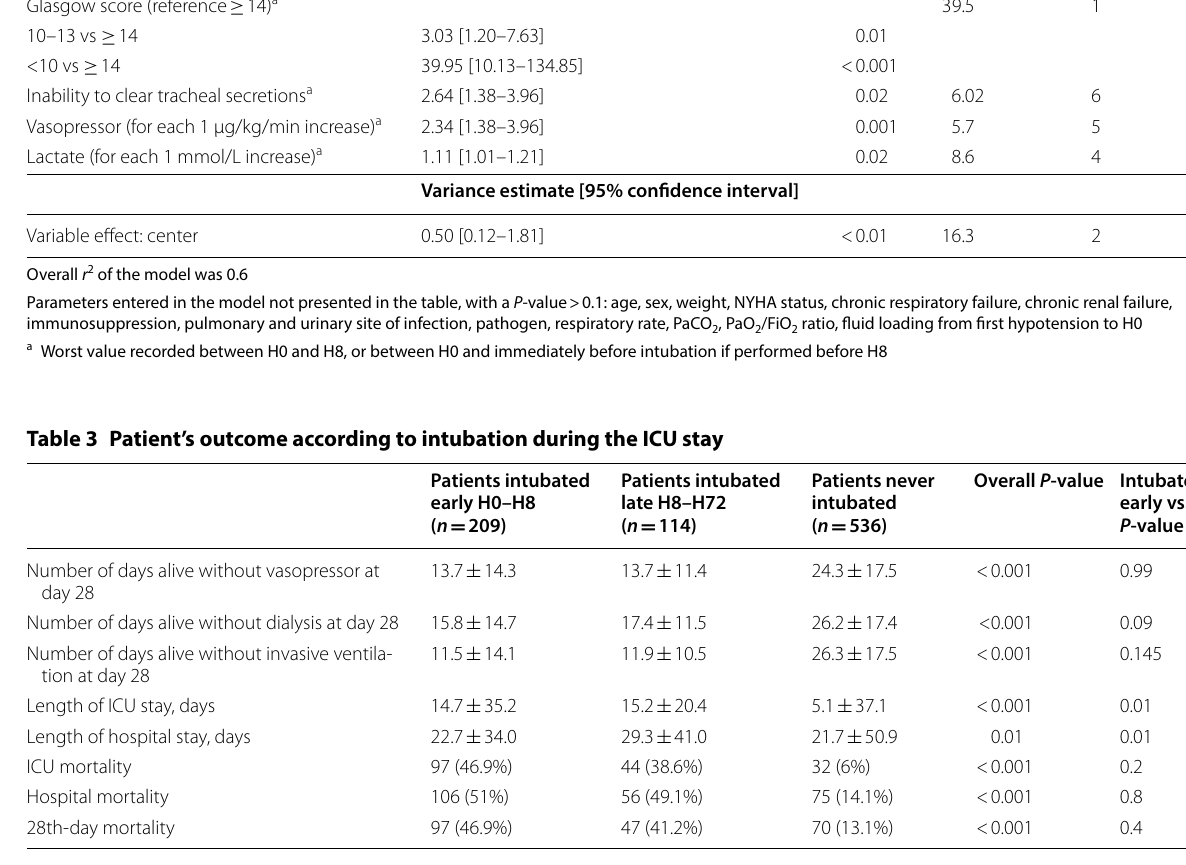
Table 2 Multivariate analysis for explaining early intubation